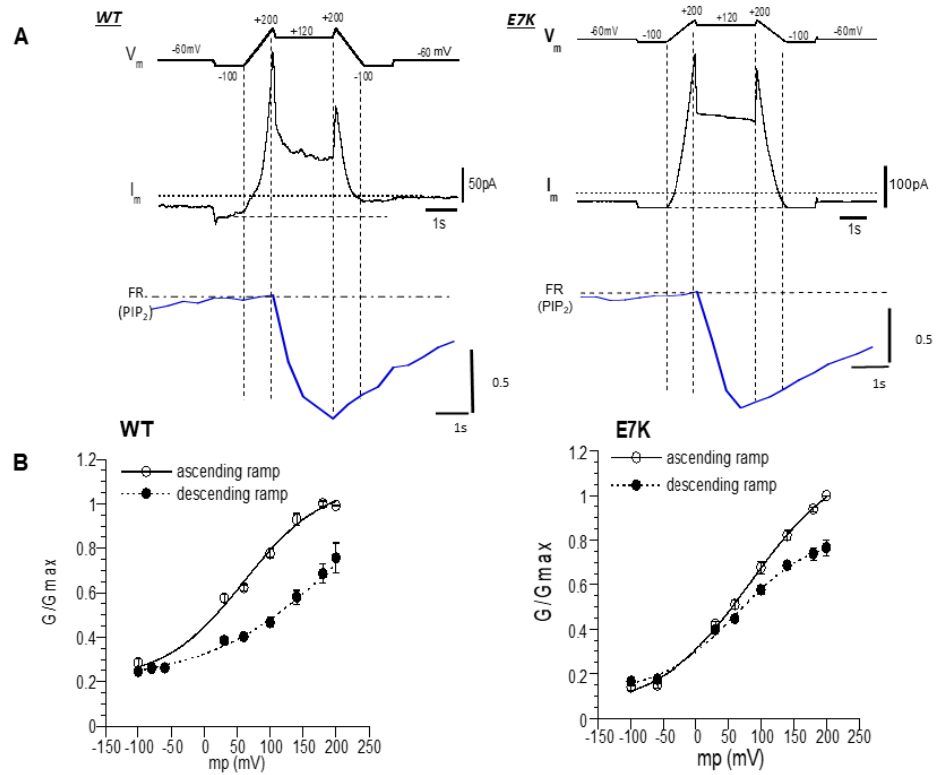
Figure 4. Different voltage dependence between the WT-TRPM4 channel and E7K-mutant TRPM4 channel after VSP-induced PIP 2 depletion. ( A ) The left and right three panels show data from WT and E7K, respectively. Top panel (V m ): a dual-ramp protocol consisting of an ascending ramp of 1 s, sustained depolarization at +120 mV for 2 s, and a descending ramp of 1 s. The ramps spanned between −100 and 200 mV. Middle and bottom panels (I m and FR): representative simultaneous recordings of membrane currents and FRET ratios (which represent the endogenous PIP 2 level) during V m changes. ( B ) Chord conductance (G)-V m relationships for WT- and E7K-mutant TRPM4 channels before (open circles) and after (filled circles) DrVSP-mediated PIP 2 depletion. The values of G/G max were calculated from the data as shown in A, and the G max was taken as the maximal G value at 200 mV of the ascending ramp. After PIP 2 depletion, the voltage dependence of the WT-TRPM4 channel was remarkably rightward shifted. In contrast, this shift was only marginal for E7K mutant, especially around the resting membrane potential. After fitting of these G-V data to the Boltzmann equation: G/G max = G 0 /G max + (G max − G 0 )/(1 + exp((V 0.5 − V m )/s) (V m , V 0.5 , s: membrane potential, half-maximal activation voltage, slope factor, respectively), the V 0.5 values before and after DrVSP activation: 62.07 ± 7.32 and 83.31 ± 9.53 vs.